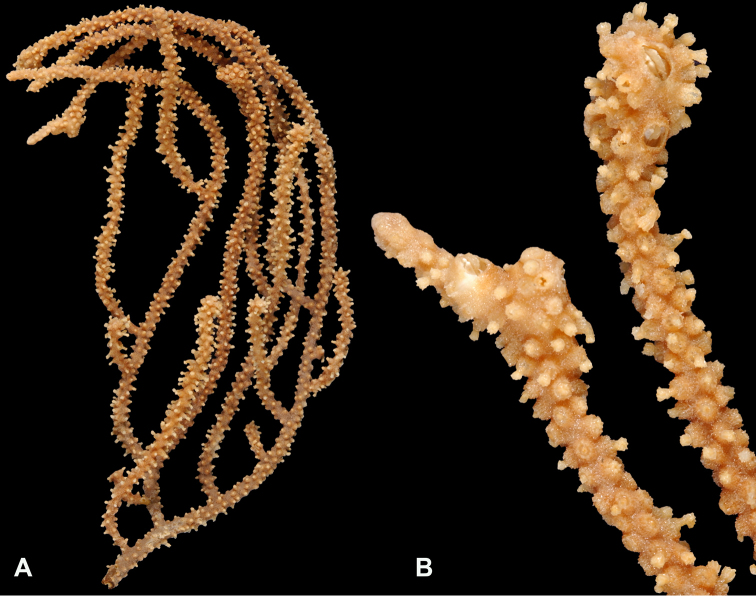
Placogorgia species A, SBMNH 422970. A Colony measures 28 cm tall (excludes missing base) × 9.0 cm broad B Magnification of branch tips; one tip malformed due to presence of barnacle gall.